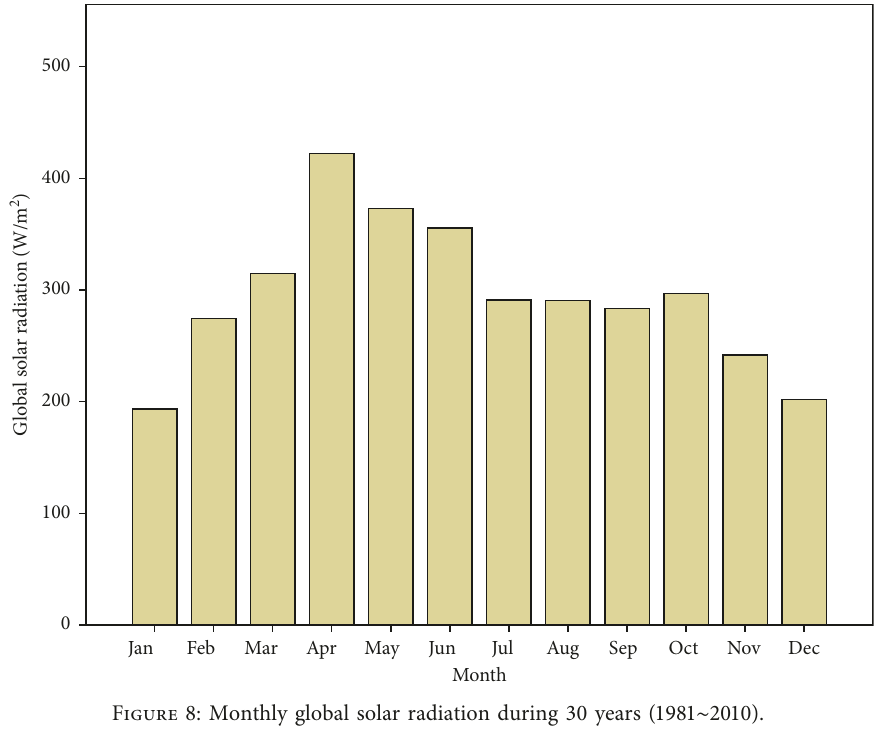
Figure 8: Monthly global solar radiation during 30 years (1981 ∼ 2010).